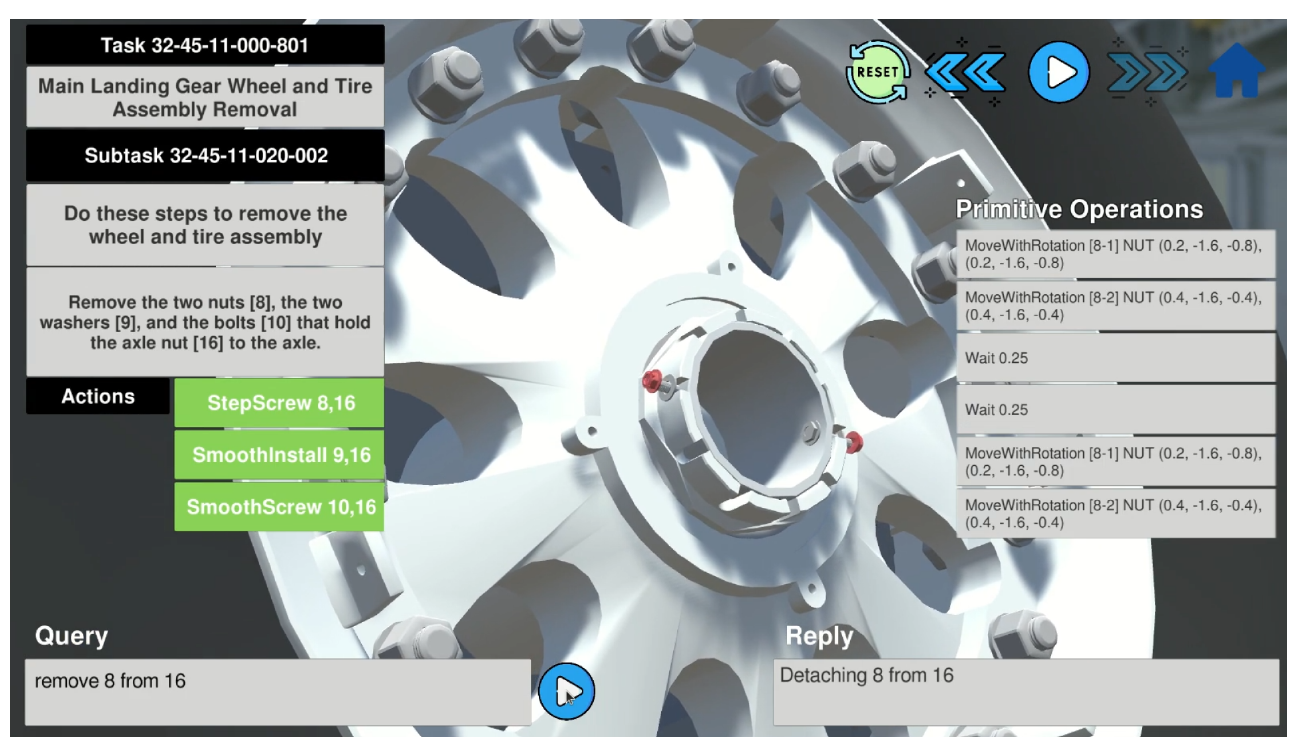
Figure 7. Digital twin interaction